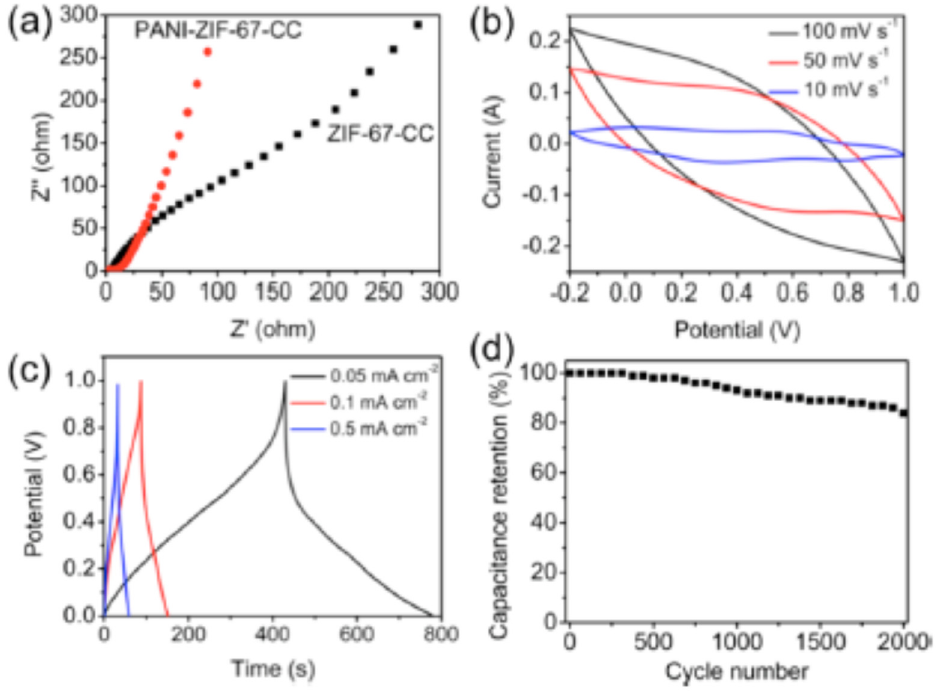
Figure 22. The SC performance of the prepared (PANI)-cobalt-based MOF crystals (ZIF-67)–carbon cloth (CC) electrode. ( a ) Nyquist electrochemical impedance spectra of ZIF-67-CC and PANI-ZIF-67-CC. ( b ) Cyclic voltammograms collected of the PANIZIF- 67-CC electrode at a different scan rate in 3MKCl. ( c ) Galvanostatic charge/discharge curves of the solid-state SC device at different current densities. ( d ) Cycling performance of the solid-state SC device measured at 0.1 mA cm − 2 for 2000 cycles [100]. Reproduced with permission.